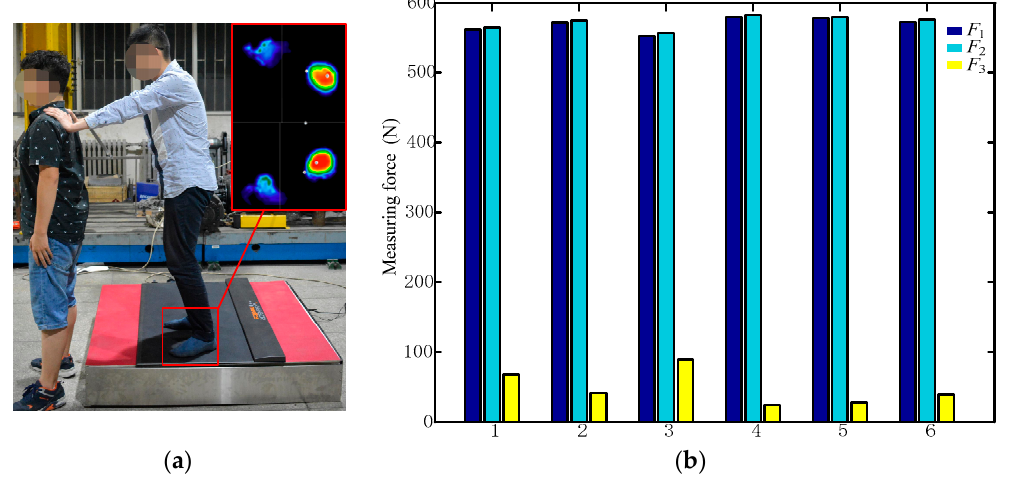
Figure 19. Testing the force distribution when a standing person pushes on another person: ( a ) experimental conditions. ( b ) Comparison of measured values from the force plate and proposed sensor under these conditions. Table 10. Comparison of measured values from the force plate and proposed sensor when a standing person pushes on another.